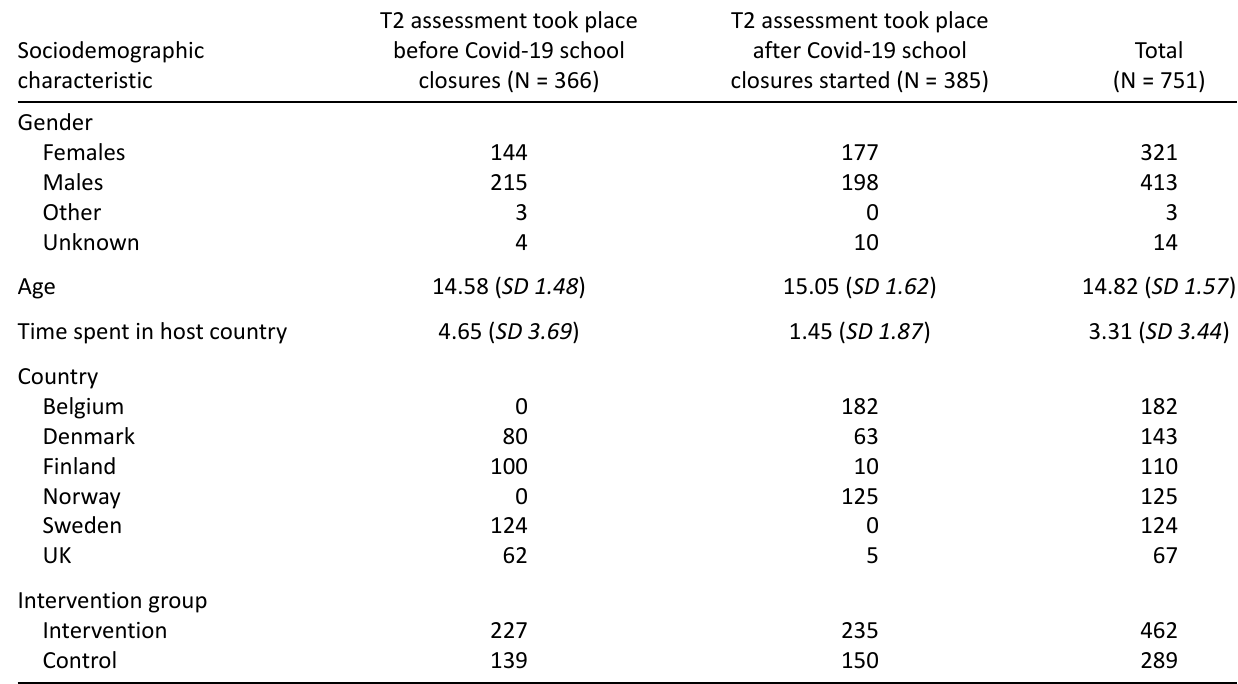
Table 1. Sociodemographic characteristics per T2 assessment Covid‐19 group (N = 751). T2 assessment took